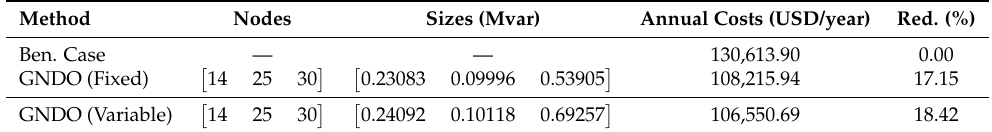
Table 6. Additional improvements reached when variable reactive power is used for daily compensa- tion with D-STATCOMs for the radial grid